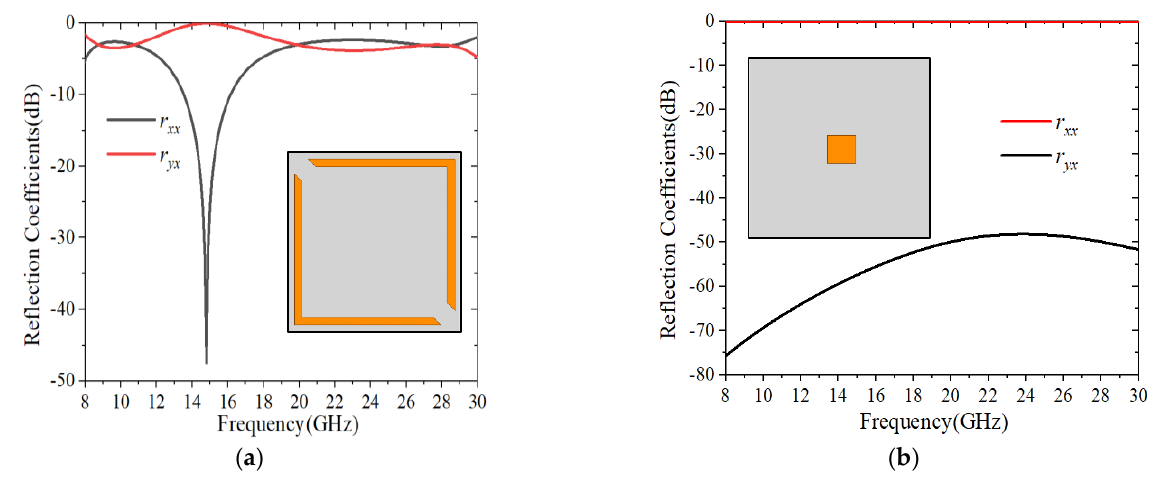
Figure 2. Reflection coefficients for: ( a ) Split square ring array; ( b ) Square patch array.